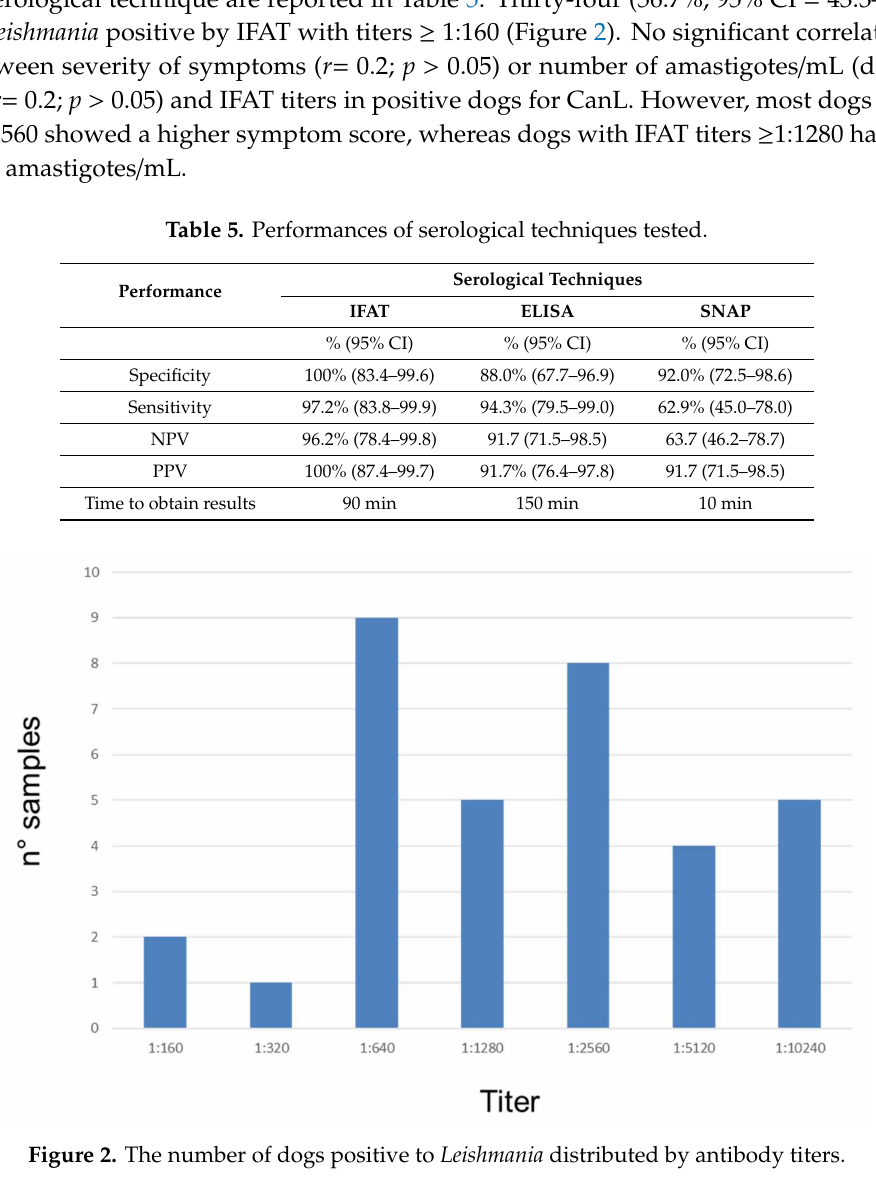
Figure 2. The number of dogs positive to Leishmania distributed by antibody